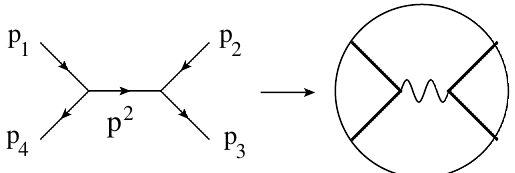
Figure 6 . The factorisation singularity of u -channel diagram leads to a factorization Witten-like diagram in AdS 3 .